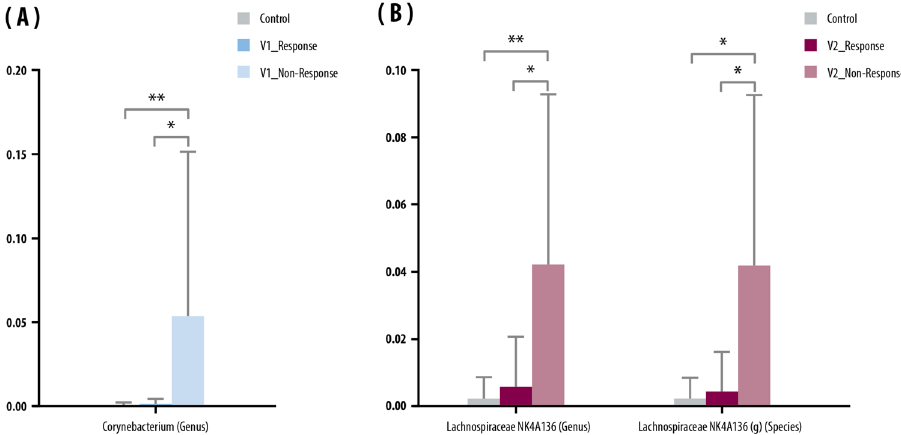
Figure 4. Serum: microbials (genus and/or species) abundant in the serum of the control and inflammatory bowel disease (IBD) groups. Mean relative abundance of: ( A ) microbials abundant in the responder group before anti-TNF-α treatment (V1); and ( B ) microbials abundant in the non-responder group after anti-TNF-α treatment (V2). Kruskal–Wallis and Wilcoxon tests were used. Bars above columns indicate standard deviation. * p < 0.05; ** p <